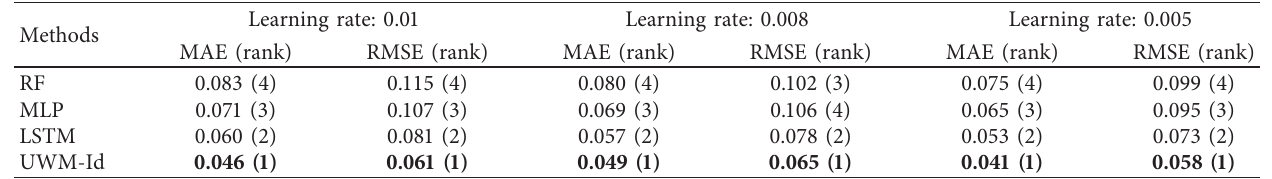
Table 4: Experimental results with the ratio of 7:3 between training set and test set.